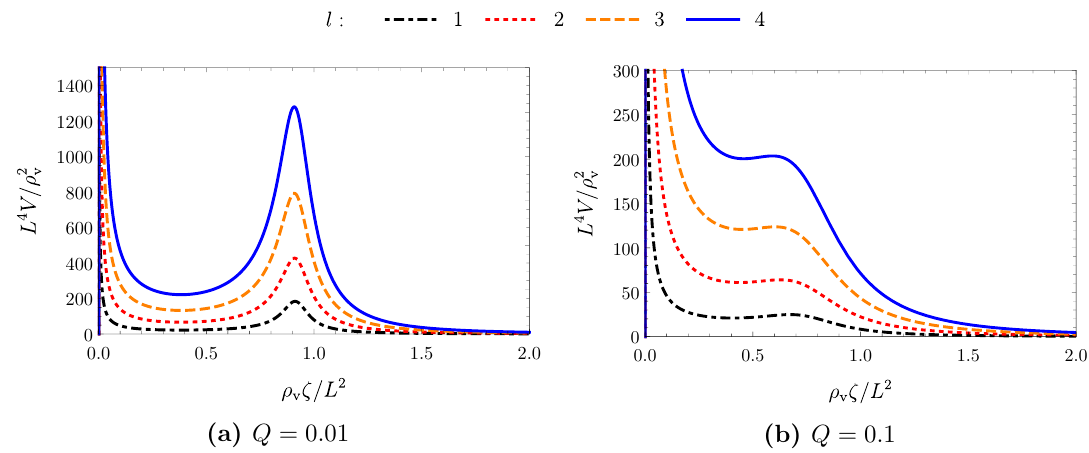
=L 4 , as a function of v